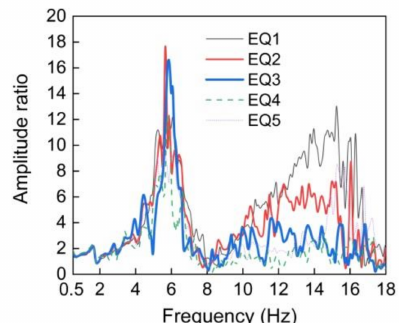
Figure 13. The amplitude ratios of the transfer function of the acceleration measured at A-1079 (pile top) and A-0 (bottom of the model box) in the 2# model during centrifuge